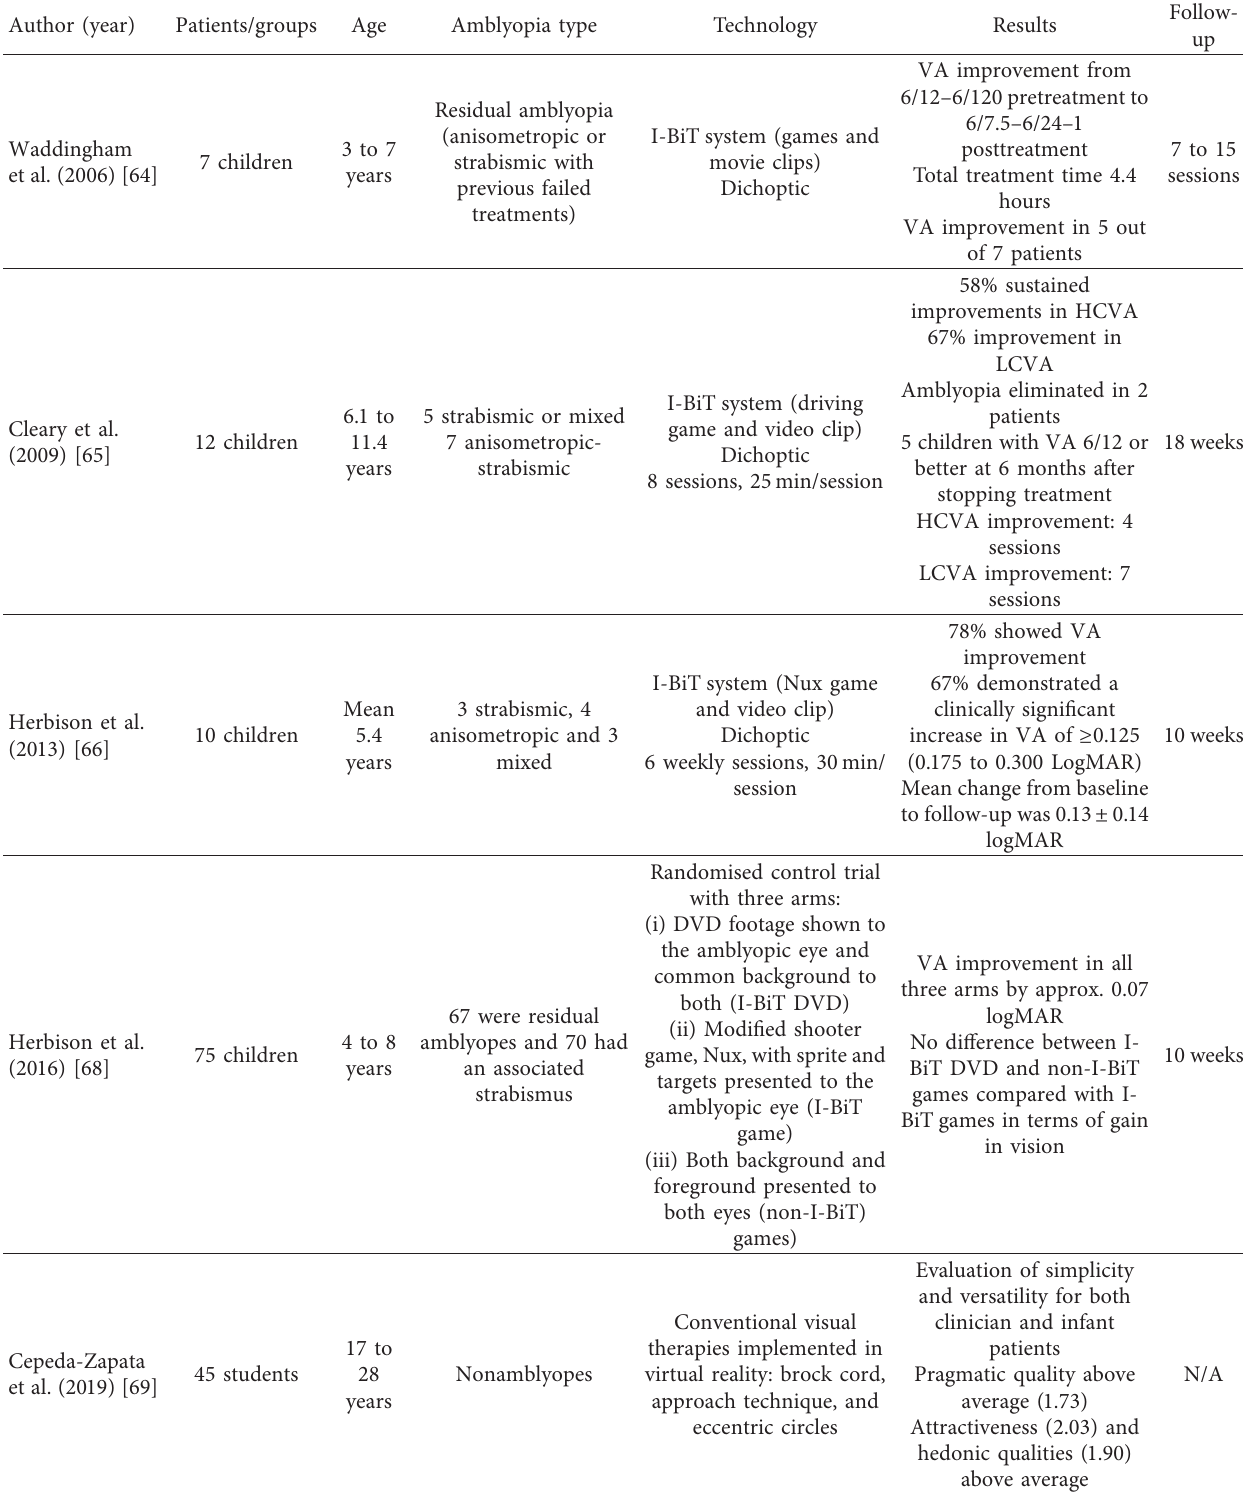
Table 1: Summary of the clinical studies conducted to this date to evaluate the use of virtual reality technologies for the treatment of